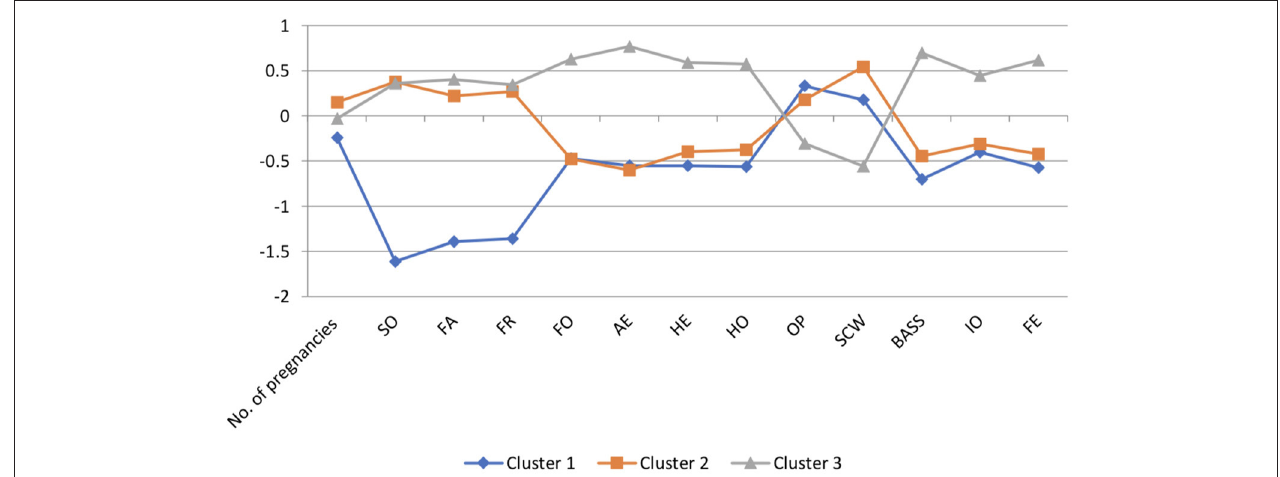
FIGURE 3 | Graphic image of the selected clusters in the group of women diagnosed with DRAM ( N = 345). Negative values are due to variable standardization. Self-assessment of the overall appearance and its individual parts: Appearance Evaluation (AE), assessment of satisfaction with appearance; Appearance Orientation (AO), assessment of care for appearance; Body Areas Satisfaction (BASS), assessment of satisfaction with specific body areas. Self-assessment of the health condition of the body: Health Orientation (HO), assessment of the care and commitment of a person to a healthy lifestyle; Health Evaluation (HE), self-health assessment; Illness orientation (IO), assessment of sensitivity to disease symptoms and focus on the disease; Fitness Orientation (FO), assessment of effort in building and maintaining care for one’s own physical fitness; Fitness Evaluation (FE), assessment of one’s own physical fitness. Self-assessment of body weight and level of fear of gaining weight: Self-Classified Weight (SCW), assessment of own body weight from underweight to overweight, assessment of where a person places themselves on the underweight-obesity scale, and their beliefs about how they would rate their weight others; Overweight Preoccupation (OP), preoccupation with being overweight and assessing the level of fear of gaining weight, the frequency of monitoring your own weight (weight vigilance), the use of various diets and dieting; SO, social support from the partner; FA, social support from the family; FR, social support from